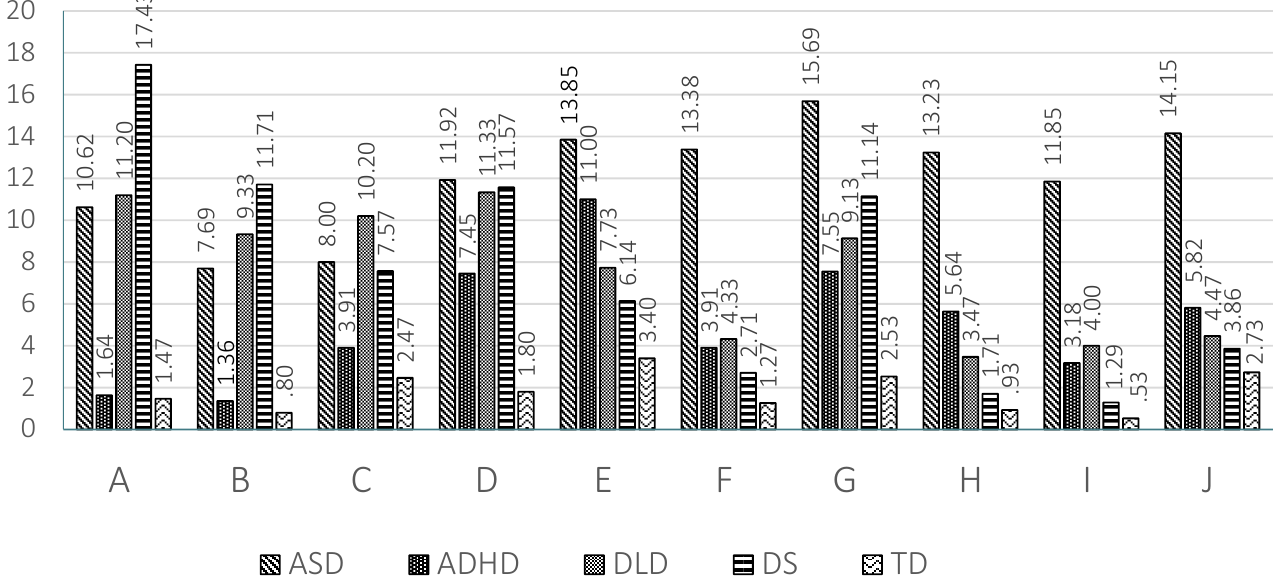
Figure 1. Means obtained by the 5 groups at preschool age in the 10 scales of the Galician